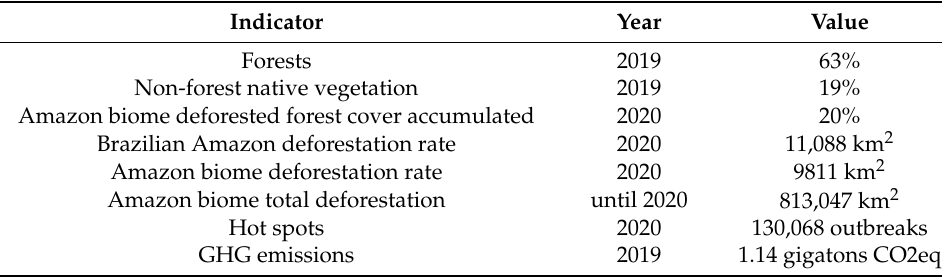
Table 10. Brazilian Amazon environmental indicators. Source: [21].